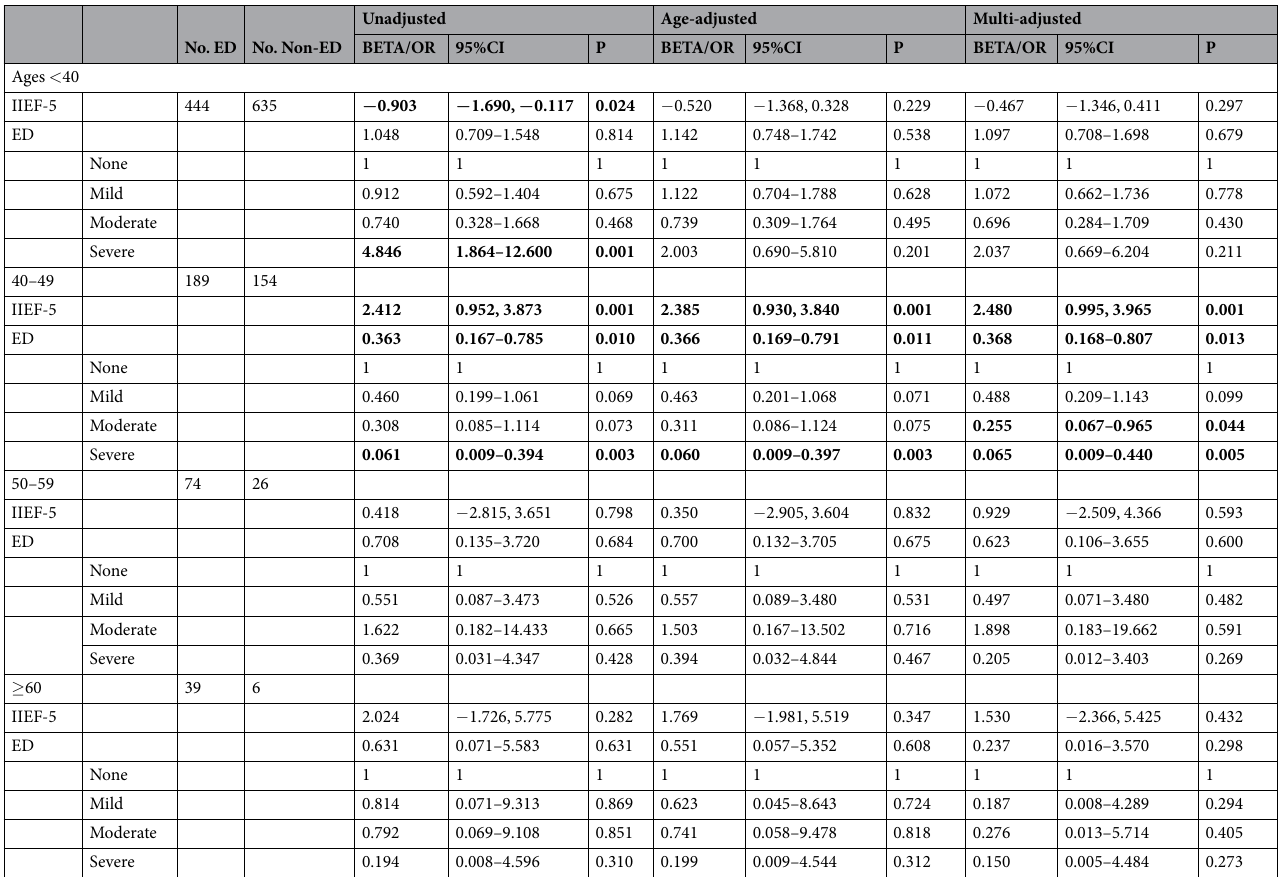
Table 5. Association between ED and osteocalcin level in four ages groups ( < 40, 40–49, 50–59 and ≥ 60 years). * Linear regression analysis for the IIEF-5 scores; binary regression analysis for ED; multinomial logistic regression for the severity of symptom of ED. * ED is divided into four groups according to the IIEF-5 scores: None = 22–25 scores, Mild = 17–21 scores, Moderate = 12–16 scores and Severe = 5–11 scores. None ED is treated as the reference in the multinomial logistic regression. * ED: erectile dysfunction; BMI: body mass index; WHR: waist hip rate; OR: odd ratio; 95%CI: 95% confidence interval. * Multi-adjusted: age, BMI, WHR,